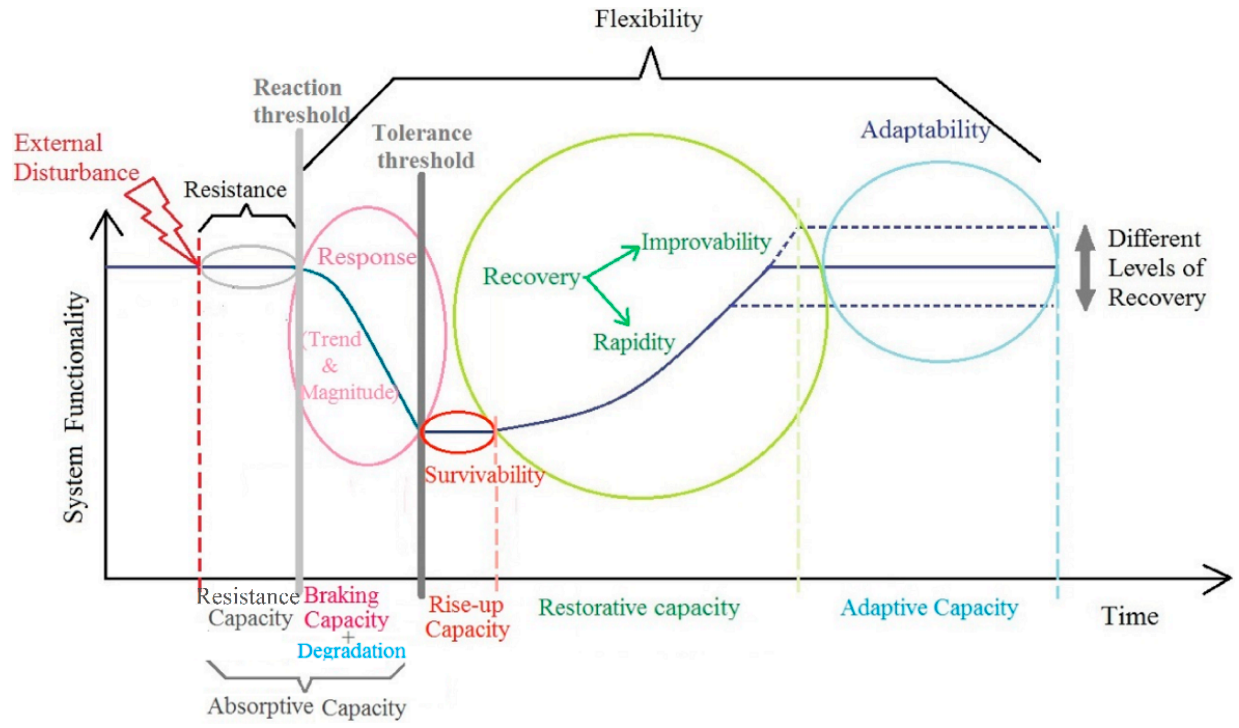
Figure 1. The system behavior in response to a disturbance.